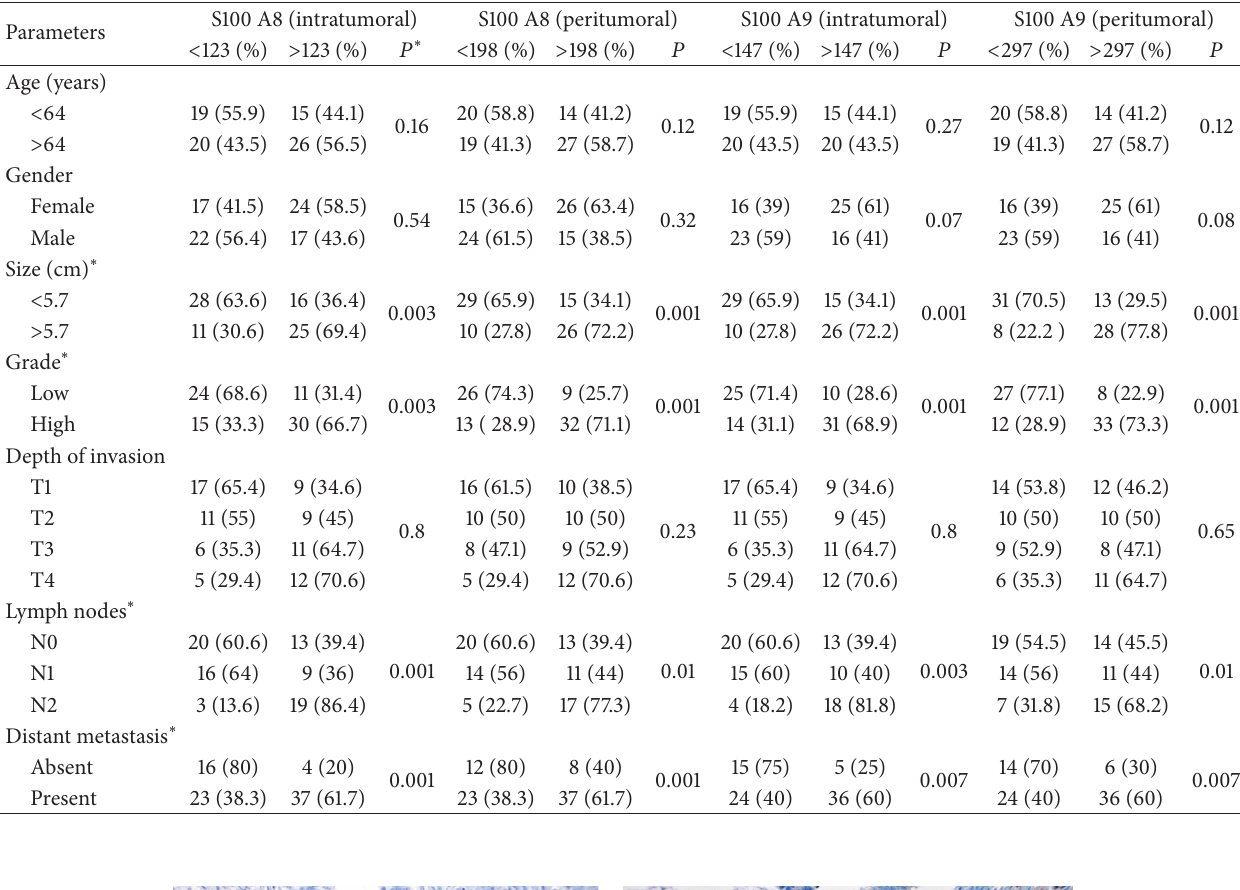
Table 2: Distribution of clinicopathologic parameters according to median values S100A8/A9 positive cells in both intratumoral and peritumoral areas. (Chi-square test, ∗ 𝑃 < 0.05 .)